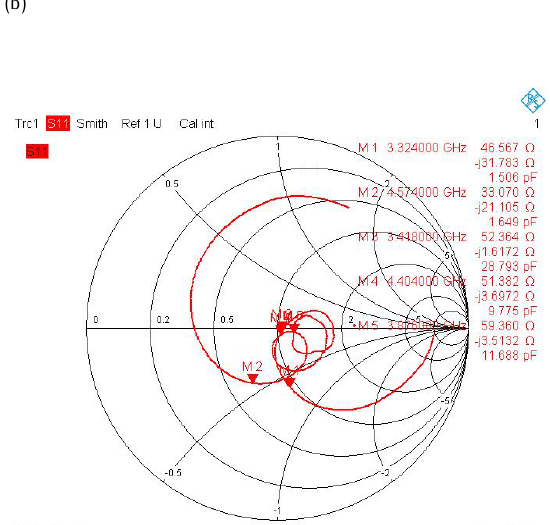
patterns of the stacked geometry at frequency 4.352 GHz are obtained as shown in Figure 9. The E-plane right circular pattern is nearly 34.3 dB down as compared to E- plane left circular pattern. This signify that radiations at frequency 4.352 GHz is left circularly polarized in nature.